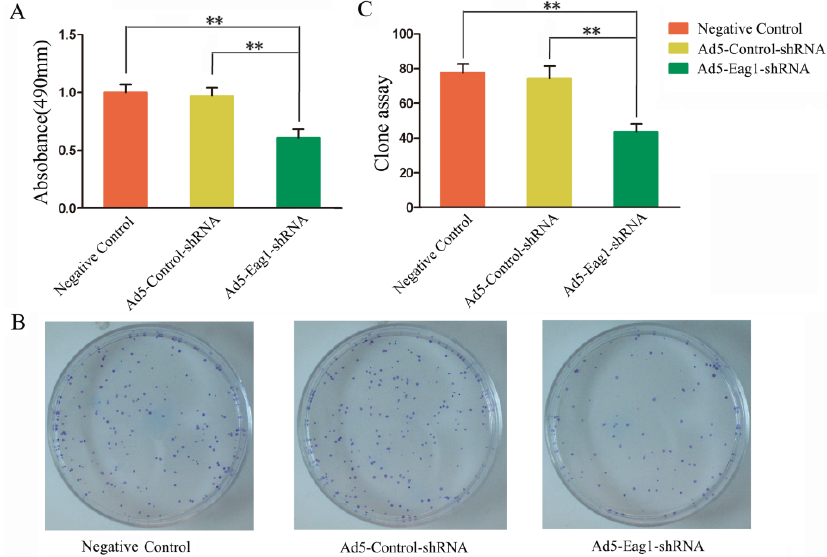
Figure 2. Eag1 blockage inhibits the proliferation and tumorigenicity of OS cells. ( A ) The proliferation of MG-63 cells was determined by CCK-8 assay. The proliferation of MG-63 cells was signi fi cantly reduced after treatment with Eag1-shRNA. Data were presented as mean ± SD ( n = 6). ** p < 0.01; ( B , C ) The tumorigenicity of MG-63 cells was determined by colony formation assay. The tumorigenicity of MG-63 cells was signi fi cantly reduced after treatment with Eag1-shRNA. Data were presented as mean ± SD ( n = 3). ** p < 0.01.